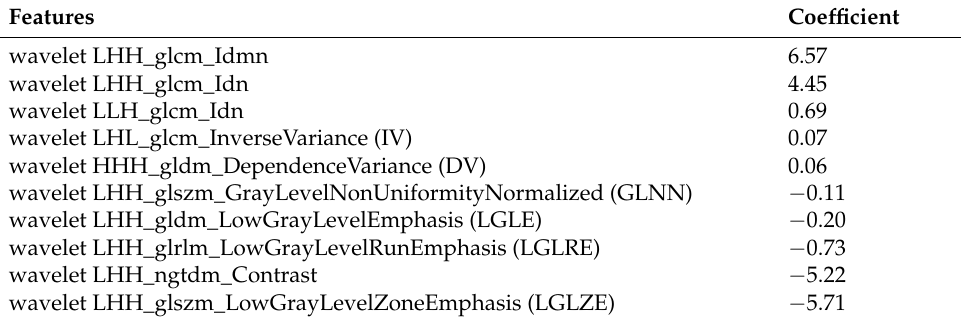
Table 2. Coefficients of adjusted radiomic